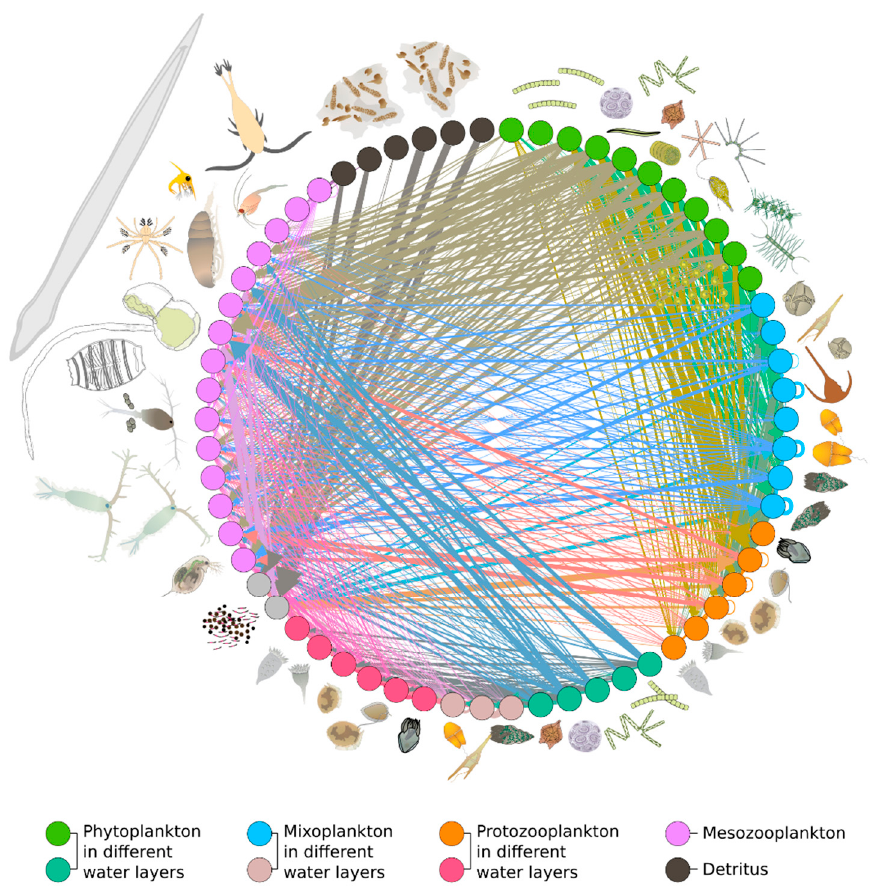
Figure 2. Plankton trophic network. Based on D’Alelio et al. 2016 [64]. Arrows go from prey to predators. Plankton drawings based on IAN libraries (https://ian.umces.edu/media-library/ symbols/, accessed on 1 November